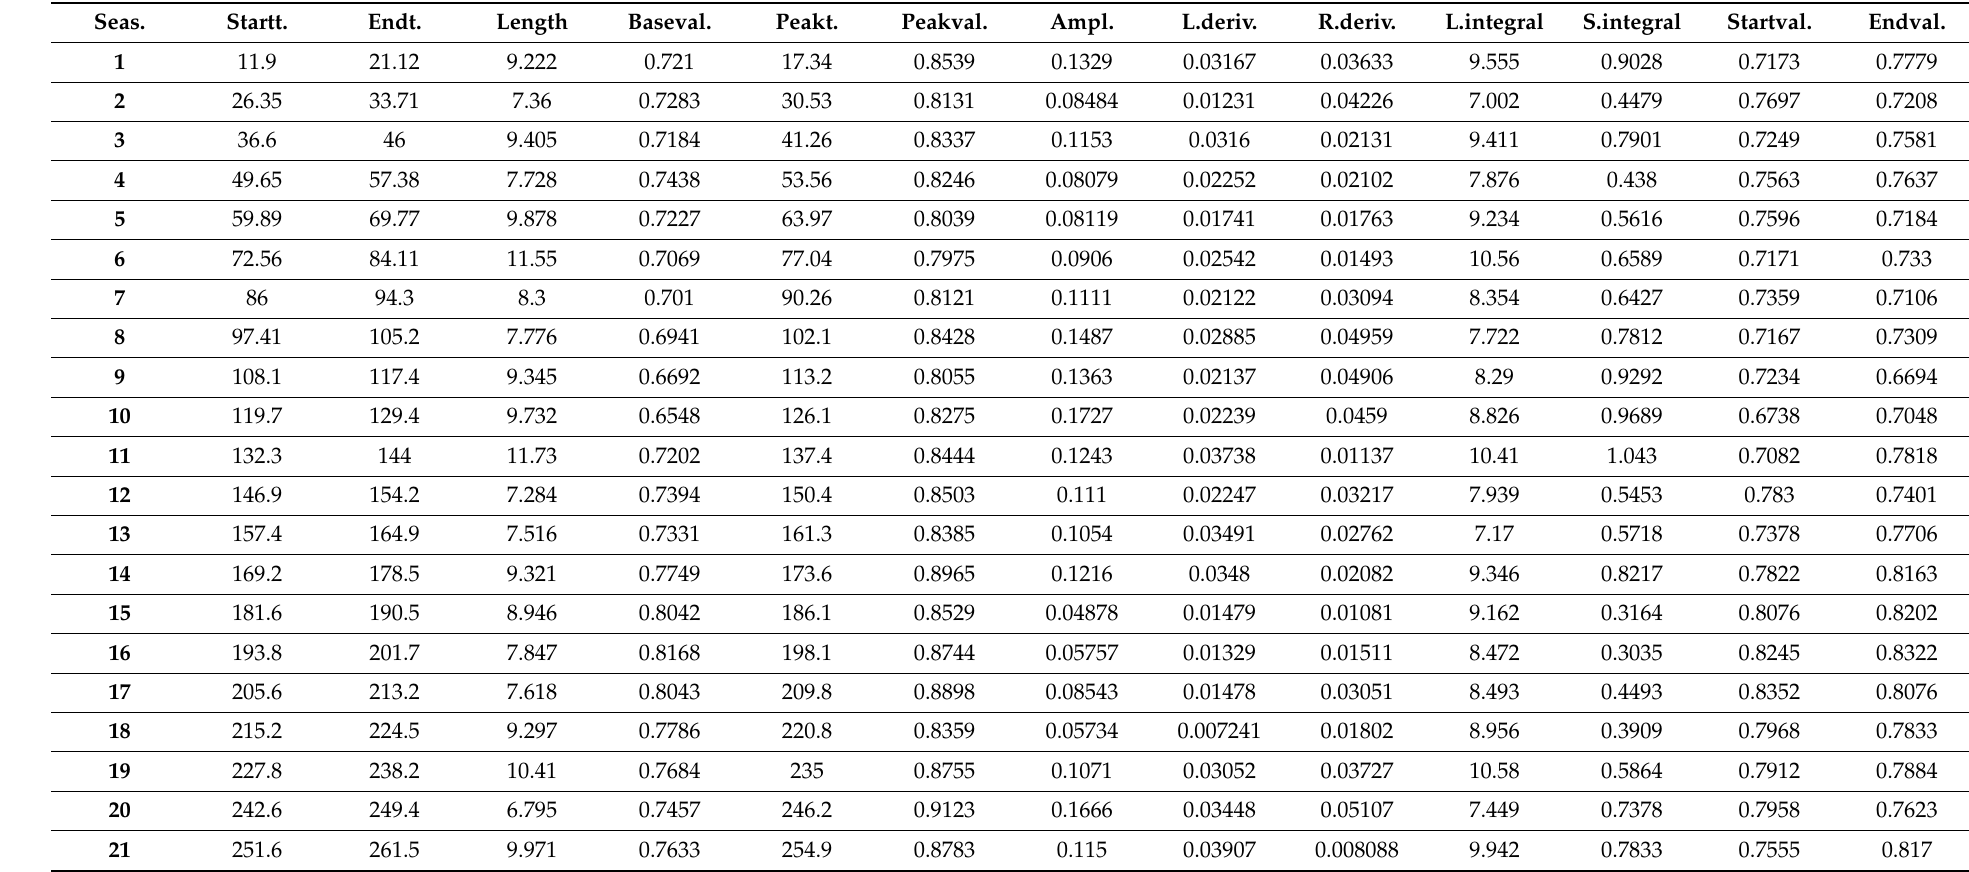
Table 3. Savitsky-Golay filter with phenometrics extracted from TIMESAT for the Landsat dense time series of mangrove forest in the mid-section of our study region, Startt.: start of season is the beginning of measurable photosynthesis in the mangrove canopy (month of the year); Endt.: end of season is the end of measurable photosynthesis in the mangrove canopy (month of the year); Length: duration of photosynthetic activity (days); Baseval.: the average of the minimum values left and right of the season (NDVI); Peakt.: time of maximum photosynthesis in the canopy (days); Peakval.: the maximum recorded NDVI value (NDVI); Ampl.: the maximum increase in canopy photosynthetic activity above the baseline (NDVI); L.deriv.: growth rate (day/NDVI); R.deriv.: rate